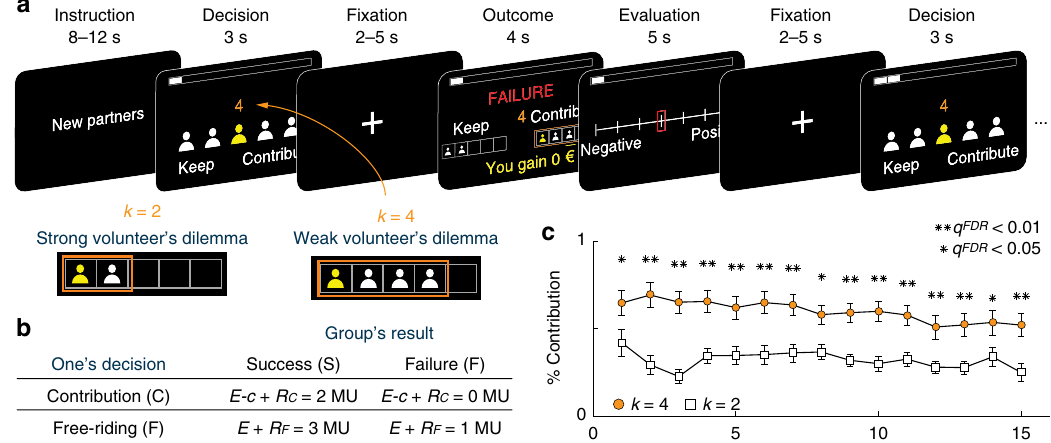
Fig. 1 Task design and behavioral results. a Representative trial and timeline of the public goods game (PGG). The level of volunteer ’ s dilemma is modulated by the decision threshold, k ( k = 2 or k = 4), which is the minimal number of contributors required to produce public goods. When the outcome is revealed, the choice of the participant is indicated by the yellow person, and the choices of others are indicated by the white persons. The orange rectangle represents the decision threshold k needed to implement the PGG. b The payoff matrix of PGG. The payoffs depend on the participant ’ s decision and on whether the mutual contribution exceeds the stated minimum ( k ) or not. On each trial, participants were endowed 1 monetary unit ( E = 1 MU). They made a binary decision between contribution and free-riding. The cost of contribution was 1MU ( c ). The group reward is R C when a participant contributes, and R F when the participant free-rides. Every member of the group gets the reward ( R = 2MU) when the group succeeds to generate public goods, and the group reward is 0 MU when the group fails to generate public goods. c Average probability to contribute in each round. The weaker the volunteer ’ s dilemma ( k = 4) the more contribution decisions participants made during PGG. The contribution rate decayed faster when confronted to a weaker ( k = 4) compare to a stronger ( k = 2) volunteer ’ s dilemma. Error bars indicate s.e.m. which are equivalent throughout the fi gure; ** q < 0.01, * q < 0.05 FDR corrected for multiple